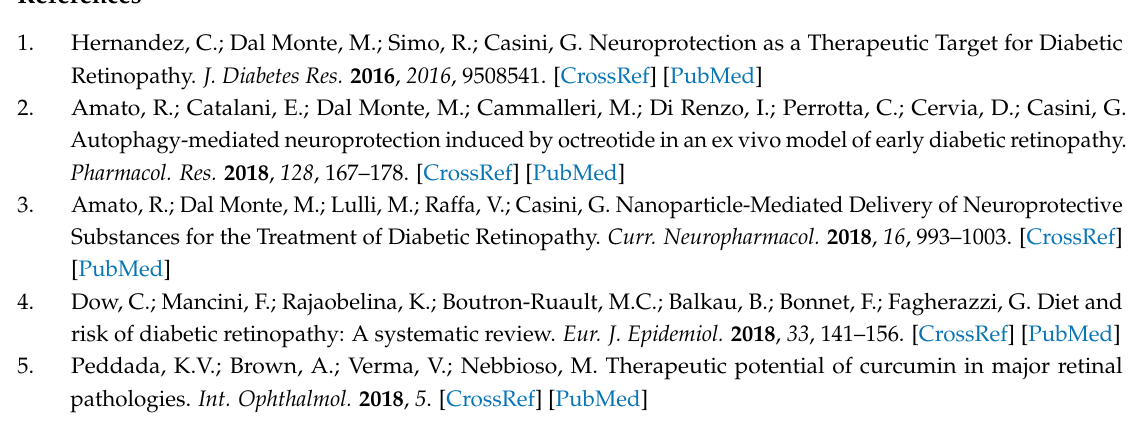
s1, Figure S1: Dose-response of Lisosan G (LG) effects on the expression of Caspase 3 mRNA ( A ) and of VEGF mRNA ( B ) in mouse retinal explants exposed to oxidative stress